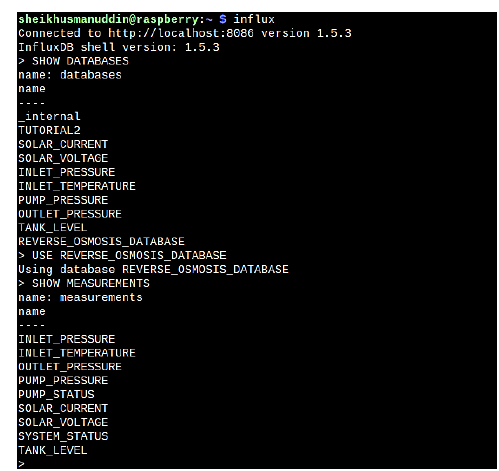
Figure 13. InfluxDB database tag generation.